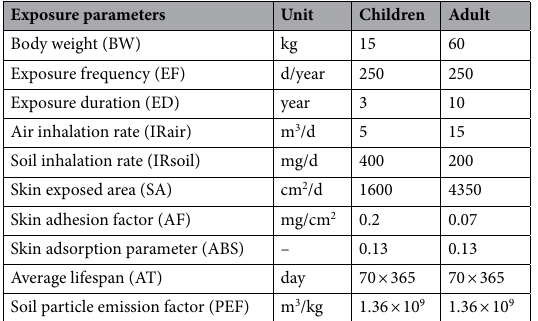
Table 4. Parameters used in lifetime carcinogenic risk